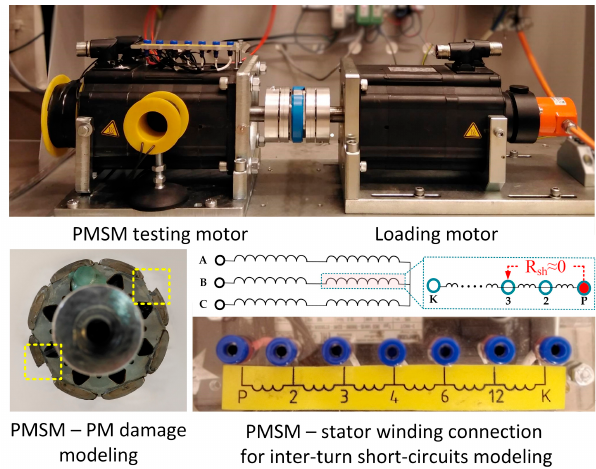
Figure 4. Experimental setup.